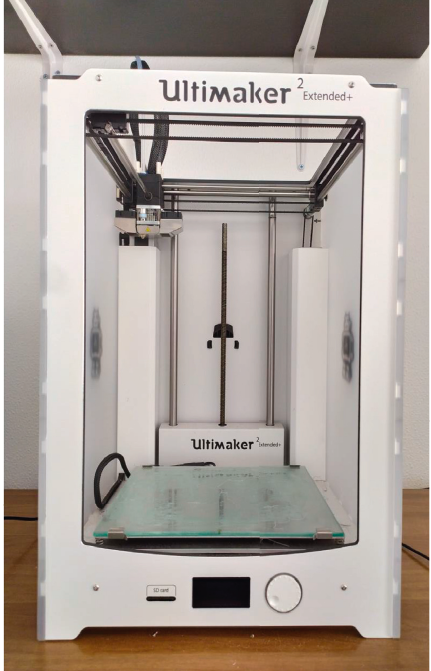
Figure 4: Ultimaker 2+ extended 3D printer.